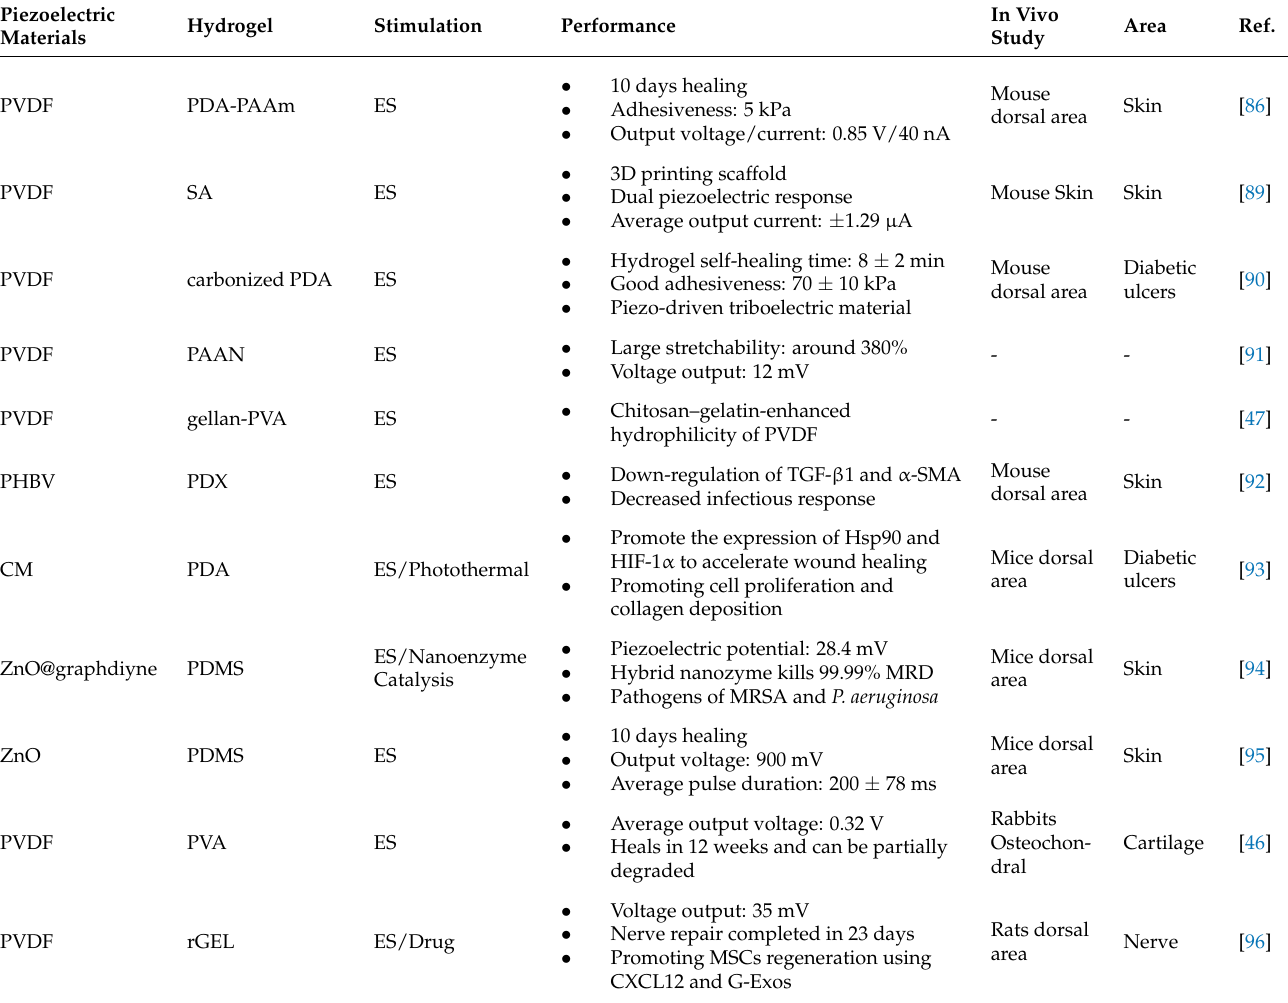
Table 3. Hydrogel-based piezoelectric devices for wound healing, different piezoelectric materials and hydrogels, the methods of stimulation, and related